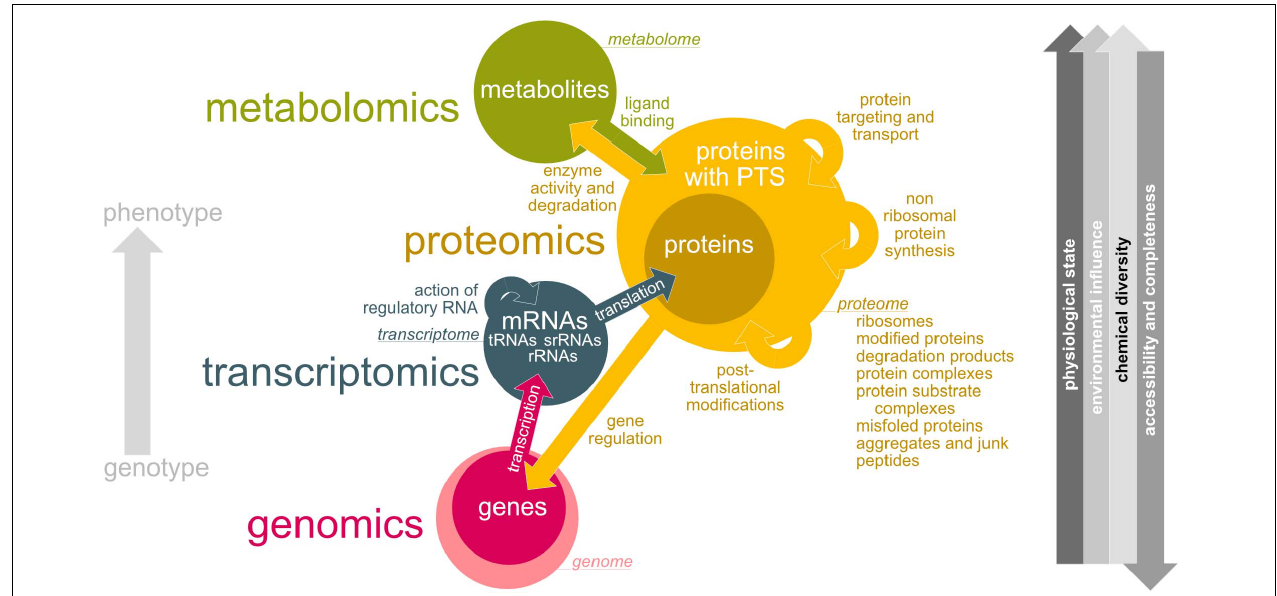
FIGURE 4 | Overview about ‘-omics’ technologies used for lichen microbiome research. Green – metabolomics, yellow – proteomics, blue – transcriptomics, pink – genomics. Colored arrows indicate interactions between metabolome, proteome, transcriptome and genome and how they are affecting each other. Circle sizes illustrate estimated complexity. Gray arrow direction (right hand side) implies an